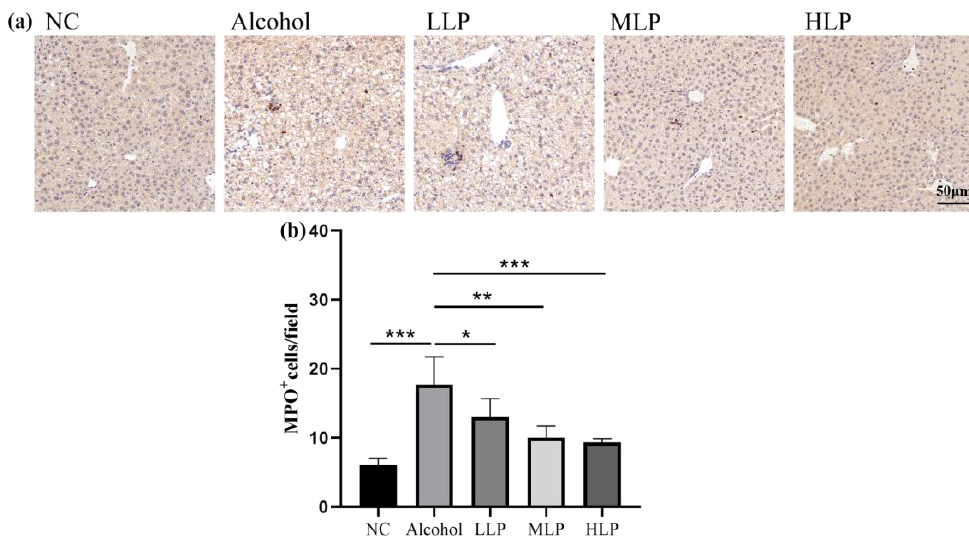
Figure 5. Effects of L. plantarum J26 on the number of MPO-positive cells in livers. ( a ): immunohisto- chemical staining of MPO.; ( b ): MPO-positive cells. NC, normal control; LLP, low-dose L. plantarum J26; MLP, medium-dose L. plantarum J26; HLP, high-dose L. plantarum J26. The data were analyzed with a one-way ANOVA and expressed as means ± SD ( n = 6). * p < 0.05, ** p < 0.01 and *** p < 0.001 compared with the Alcohol group.